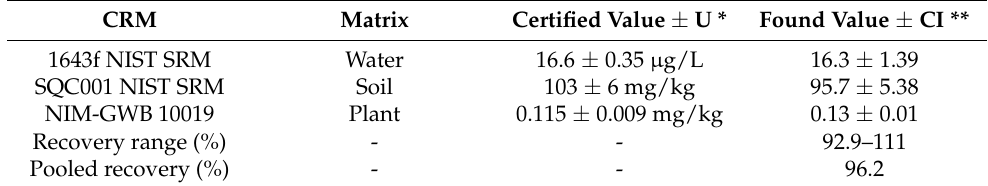
Table 4. Certified and measured concentration of Li in certified reference materials (CRMs).